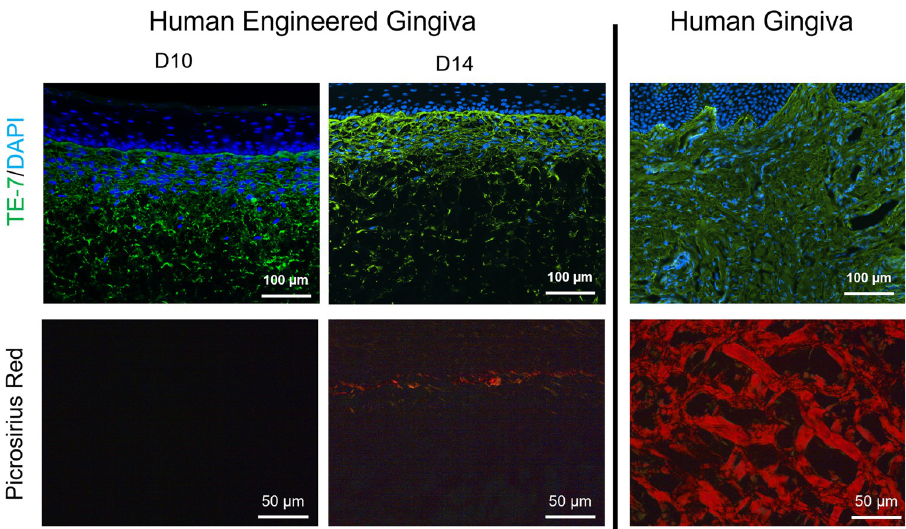
Fig 4. Comparison of stromal constituents in normal and engineered human gingiva. at Both normal and engineered gingiva showed dense fibroblast layers (positive staining for TE-7); however, gingival fibroblasts populated the upper half of the connective tissue scaffold in the engineered tissue whereas they were present throughout the stromal component in normal gingiva. Dense, mature collagen type I bundles (red staining) are observed in a cross- hatched pattern in normal human gingiva while new collagen has just begun to be deposited in the upper stromal region at day 14 in the engineered gingiva. Scale bar = 100 μ m for TE-7 stain and 50 μ m for picrosirius red